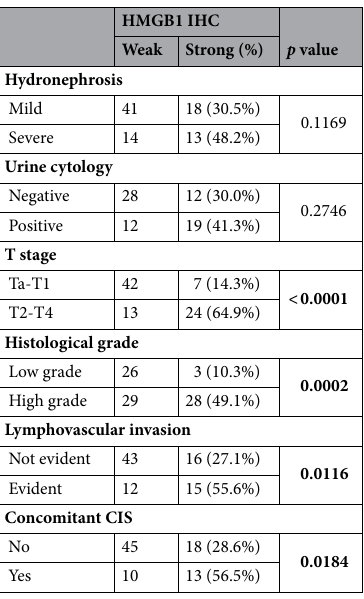
Table 5. Relationships between HMGB1 expression and clinicopathological parameters. HMGB1 high mobility group box 1, IHC immunohistochemistry, CIS carcinoma in situ. The significance of bold means p <